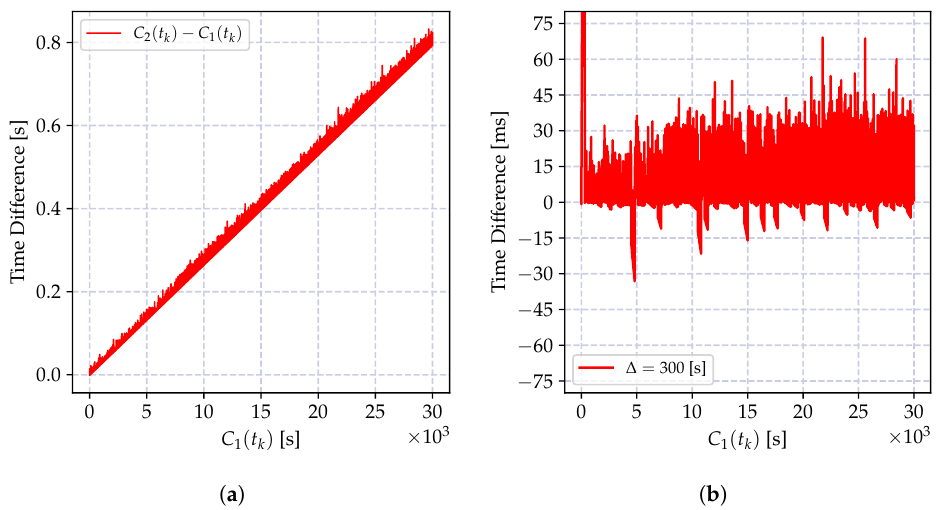
Figure 22. The results for the time data acquired using a Bluetooth low-energy transmitter and a Raspberry Pi gateway. In ( a ), the variation of time difference with the transmitter’s time C 1 ( t k ) . In ( b ), the time difference in milliseconds between the local clock time reports and the reference clock reports when the time relation parameters of the incremental time model are estimated every ∆ = 300 s using exponentially weighted recursive estimator in Equation (39a–c) with weight λ =